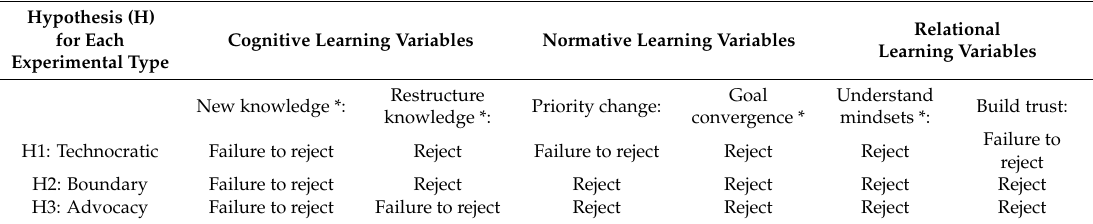
Table 5. Results for the hypothesised levels of learning for each experiment type. Asterisks (*) denote the variables that have statistically significant differences in learning levels between the